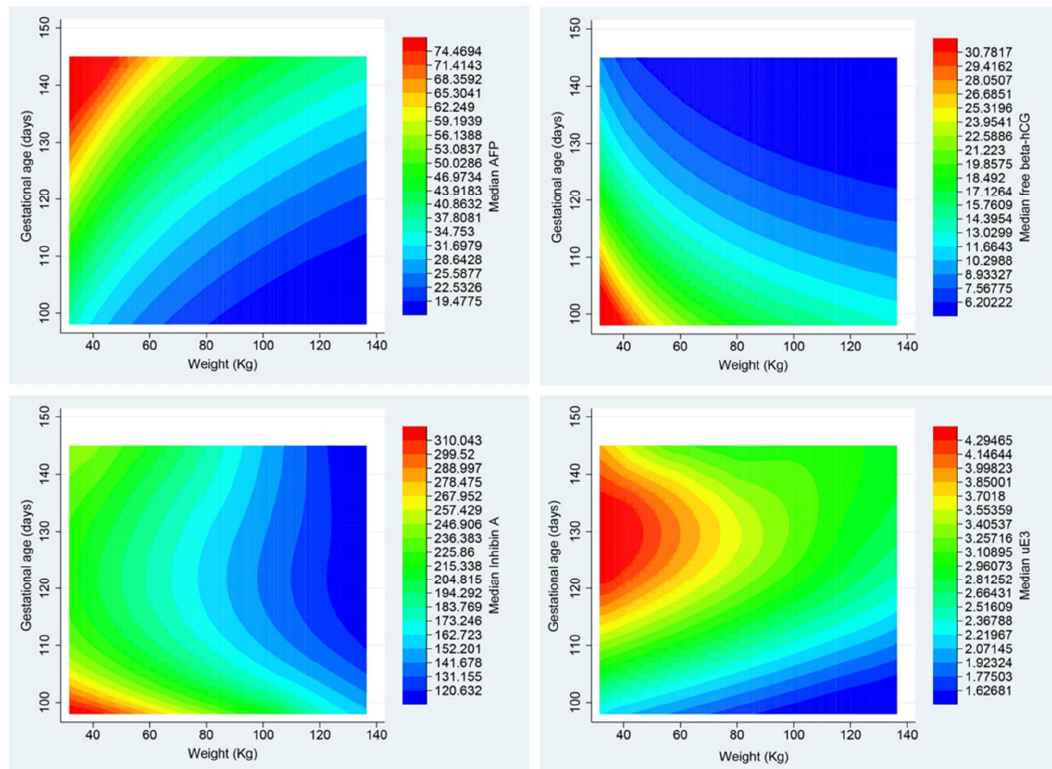
Figure 1. Rainbow contour plots of predicted median alpha-fetoprotein (AFP), free beta-human gonadotropins (beta-hCG), inhibin-A and unconjugated estriol (uE3) as a function of gestational age (days) and maternal weight (kg), based on the generated models in this study.